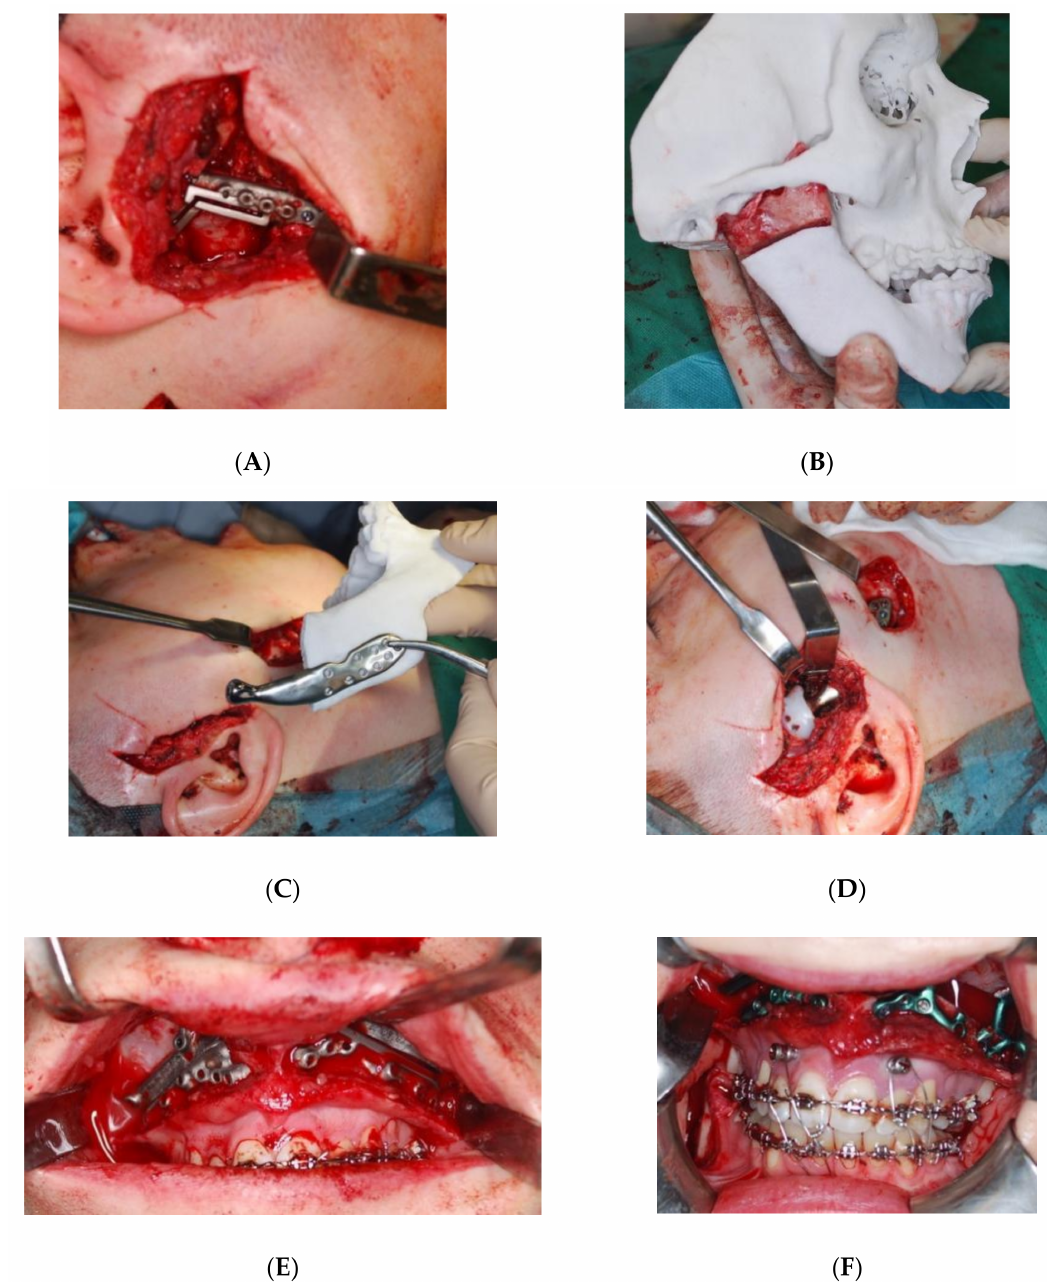
Figure 7. The same patient at a later stage of treatment. The final procedure—ankylosis resection, orthognathic surgery and placement of individual prosthesis. ( A ) Resection guide for ankylosis, ( B ) visualisation of the resected bone mass with stereolithographic model, ( C ) custom prosthesis (ChM, Poland), ( D ) custom prosthesis placed into the reconstructed fossa with custom fossa implant (ChM, Poland), ( E ) osteotomy guides for Le Fort I type osteotomy maxilla advancement, ( F ) maxilla fixed and stabilised with custom plates (ChM,